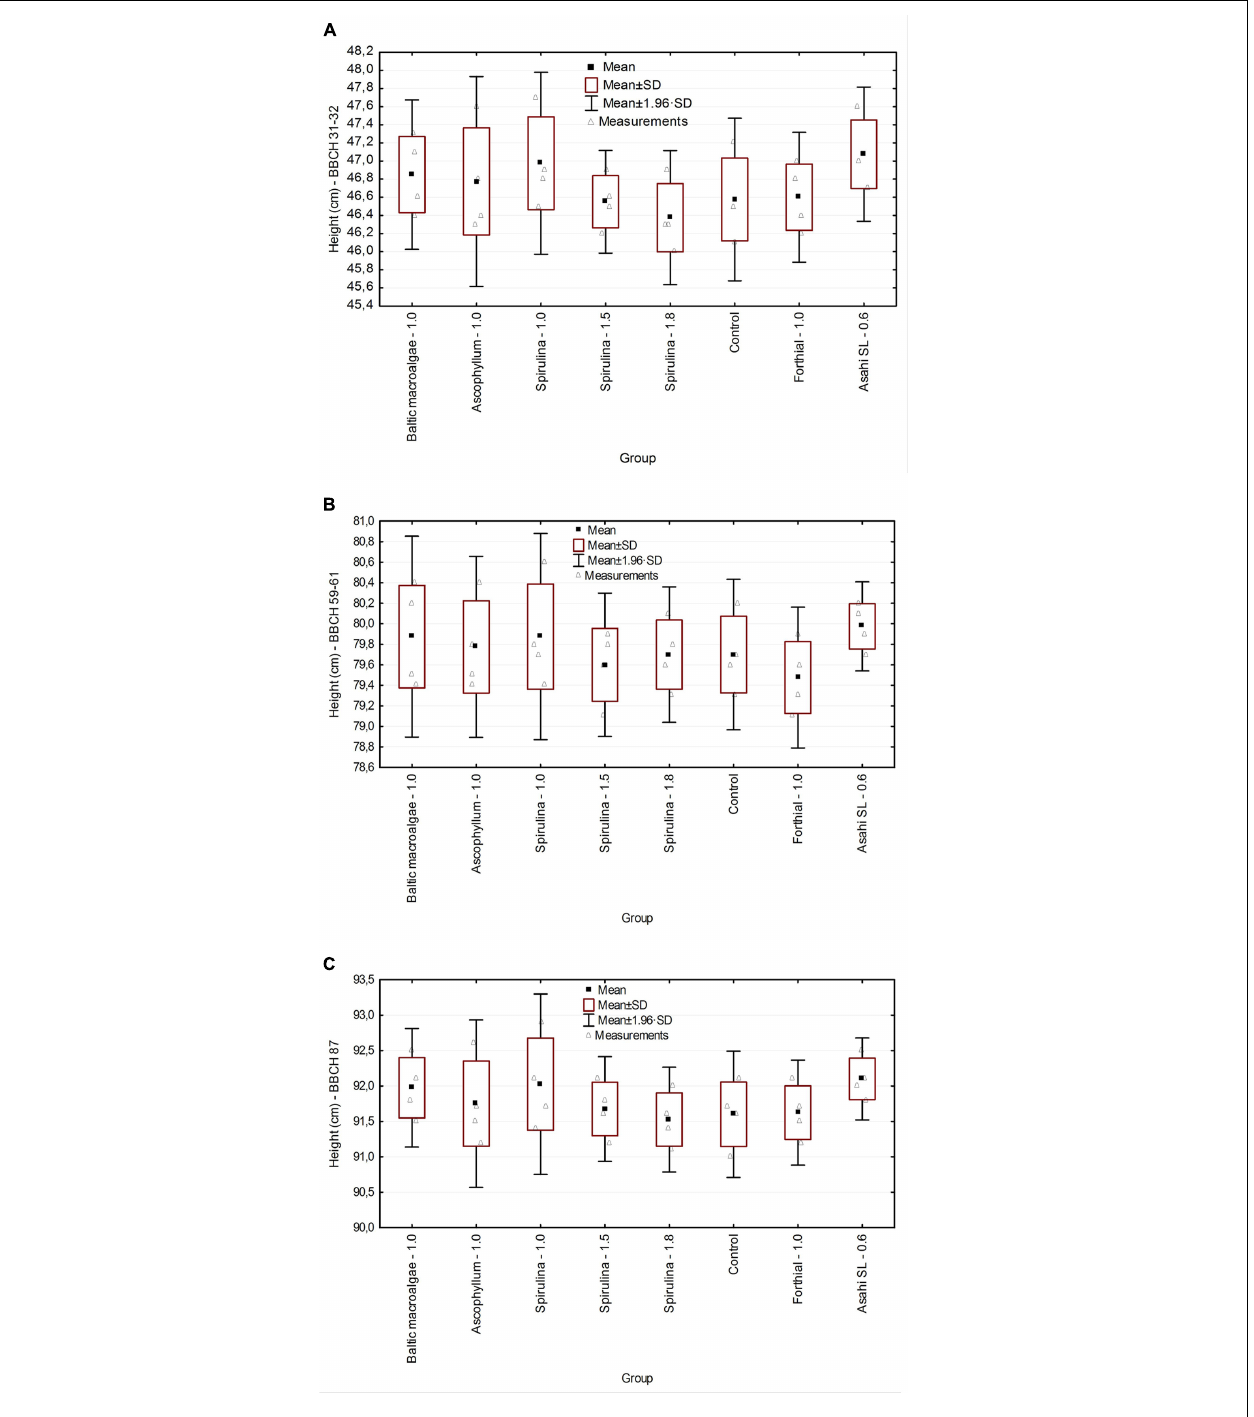
This result is in agreement with the data obtained in the growing season 2012/2013 when Spirulina extract was applied on wheat at two doses: 1.2 and 1.8 L/ha (Chojnacka et al., 2014). The ear number per m 2 for 1.2 L/ha was 3.0% higher than for